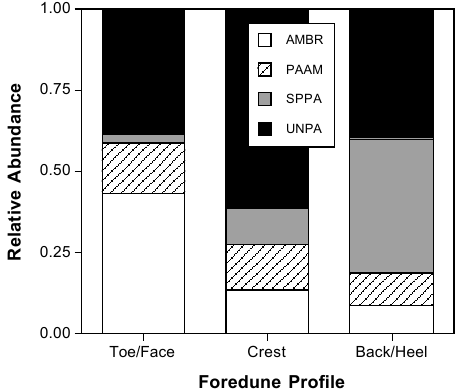
Figure 5. The distribution and relative abundance (proportional shoot density; number of shoots per total number of shoots for all dune grass species) of the dominant dune grass species (abbreviations in Figure 4) found along cross-shore profiles of foredunes that included all dune grass species within the Outer Banks islands, USA (see Table S3C for statistics).